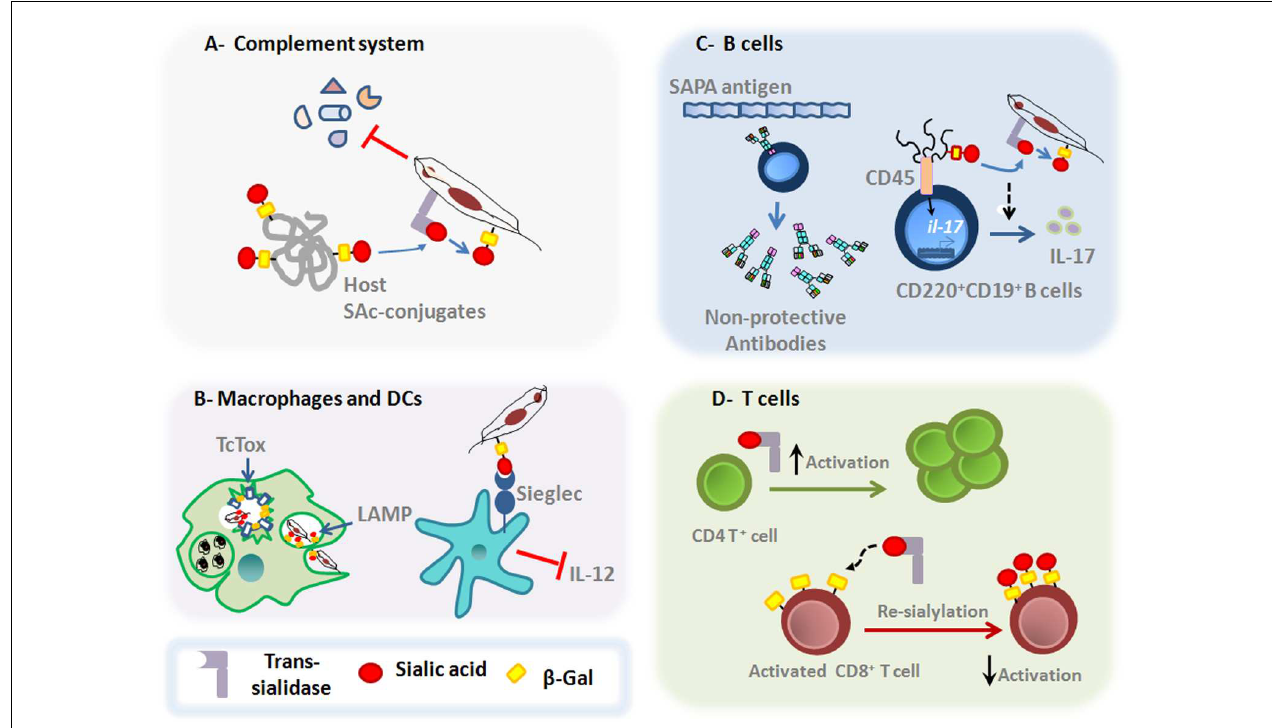
FIGURE 2 | Main roles of T. cruzi TS on the host immune responses. (A) Upon entry in the host milieu , which is rich in SAcs donors, the parasite surface gets a negatively charged barrier due to a reaction catalyzed by TS, conferring protection against the complement-mediated killing. (B) TS favors T. cruzi escape from the parasitophorous vacuole, process in which LAMP and Tc-Tox proteins are also shown to be involved. Moreover, TS is able to interfere with IL-12 secretion by dendritic cells through the interaction between sialylated molecules on T. cruzi surface and Siglecs on dendritic cell surface. (C) SAPA-antigen induces the production of non-protective antibodies. Moreover, recent findings have show that TS acts on both mature follicular and marginal zone CD220 + CD19 + B cells to induce the expression of IL-17 by a non-canonical signaling pathway. These signaling events promote changes in the glycosylation profile of CD45 that result in their phosphatase activity and subsequent activation of downstream signals leading to the Il-17 gene expression. (D) TS can also induce the activation of CD4 + T cells in vivo . In addition, TS can also promote changes in the sialylation pattern of activated CD8 + T cells, dampening the protective functions of MHC class I-dependent lymphocyte killing responses against T. cruzi